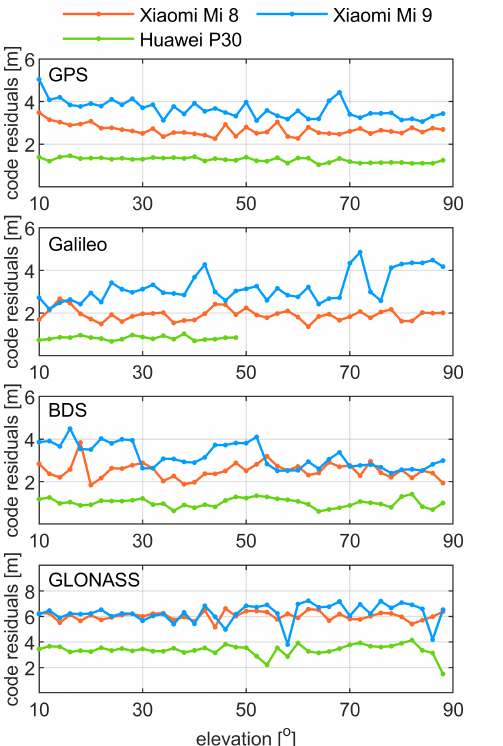
Figure 5. Elevation-dependent quality of code observations on GPS L1, Galileo E1, BDS B1, and GLONASS G1 frequency bands, respectively. Code residuals were computed as the observations that were double differenced in a time domain. The values are averaged over all satellites in 1 ◦ bins. One should note that the GLONASS panel has different axis limits of code residuals when compared to the other